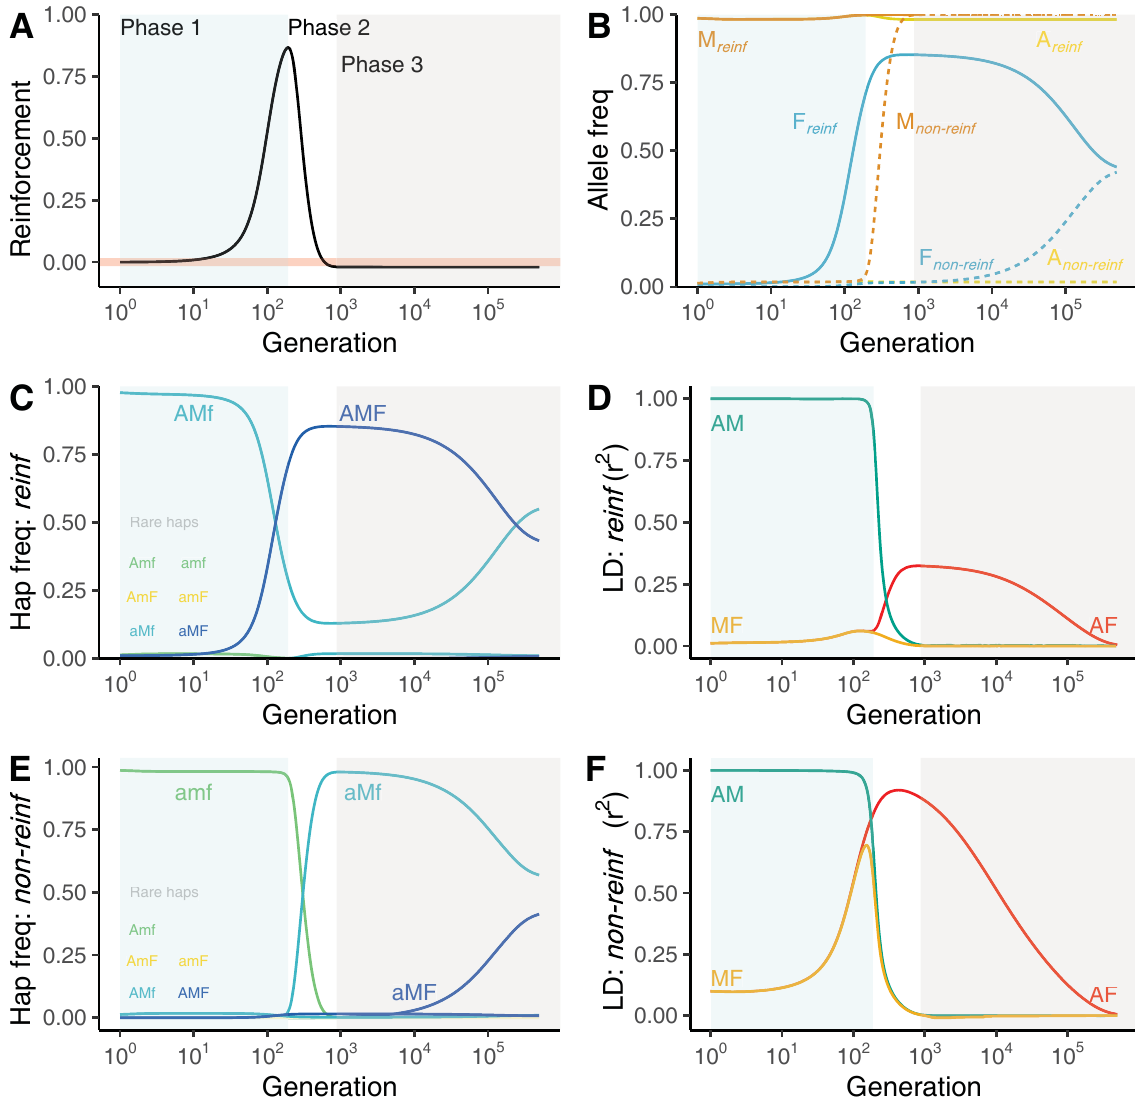
Fig 2. The rise and fall of reinforcement in 3 phases. A female barrier allele F preventing fertilization by m gametes spreads in the reinforcing population/species reinf (Phase 1: light blue). The compatible sperm/pollen allele, M , next introgresses into the non-reinforcing population/ species non-reinf and spreads (Phase 2: white). After M fixes, the barrier allele F slowly disassociates from the reinforcing background, eventually equilibrating in both populations (Phase 3: light grey). ( A ) Reinforcement is transient, building in Phase 1 and breaking down in Phase 2. The pink line shows 0 reinforcement. ( B ) Allele frequencies in both populations, with solid and dashed lines showing frequencies in reinf and non- reinf , respectively. The F allele increases in reinf followed by the global fixation of M and subsequent neutrality of F . ( C ) Haplotype frequencies and ( D ) gametic linkage disequilibrium (LD) between all pairs of loci over time in the environment of reinf . ( E ) Haplotype frequencies and ( F ) gametic LD between all pairs of loci over time in the environment of non-reinf . LD is measured as r 2 , and all measures describe populations after selection and before recombination. This figure illustrates a single set of parameter values with 1 adaptive locus. Selection: s reinf = s non-reinf = 0.75; Migration: g non-reinf ! reinf = g reinf ! non-reinf = 0.1; Recombination: r ¼ r ¼ 0 : 0001 ; Initial allele frequencies: f = 1, f = 0, f M 0,reinf M 0,non-reinf F 0, AM MF reinf = 0.01, f F 0,non-reinf = 0. The data underlying this figure can be found in https://datadryad.org/stash/dataset/doi:10.5061/dryad.rjdfn2zf8.